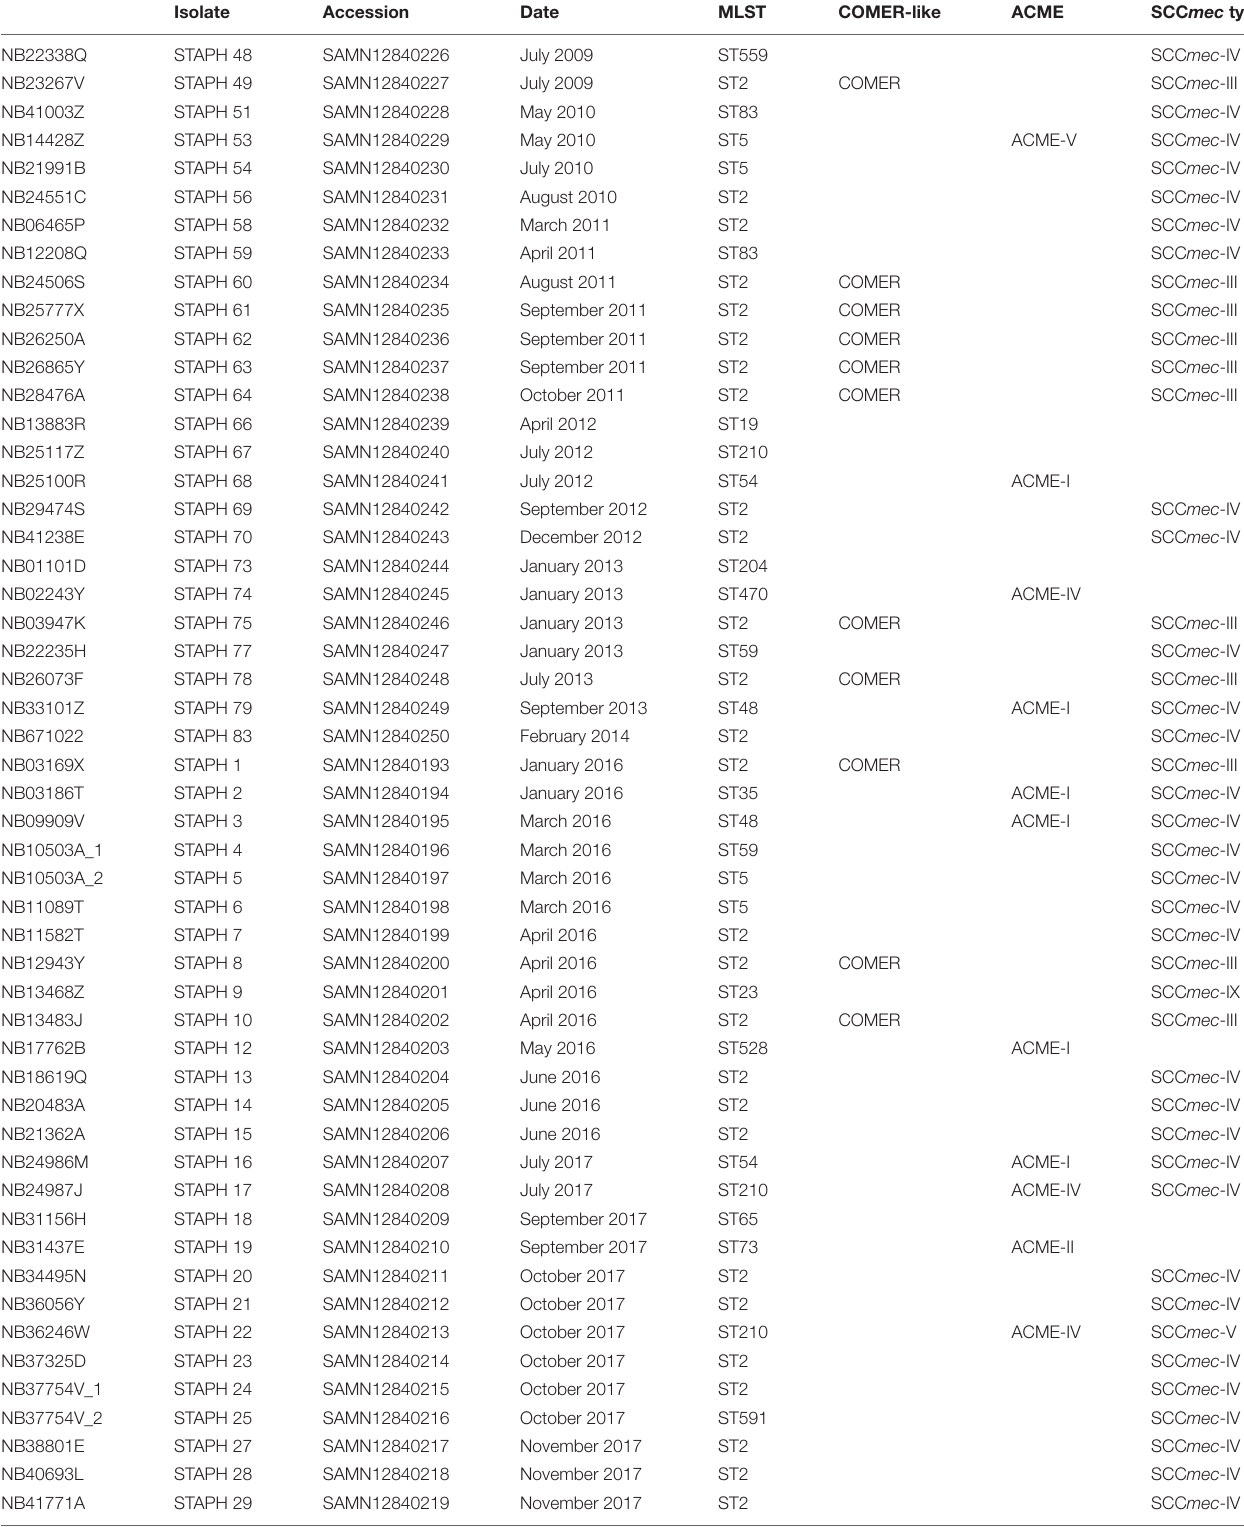
TABLE 1 | S. epidermidis isolates.